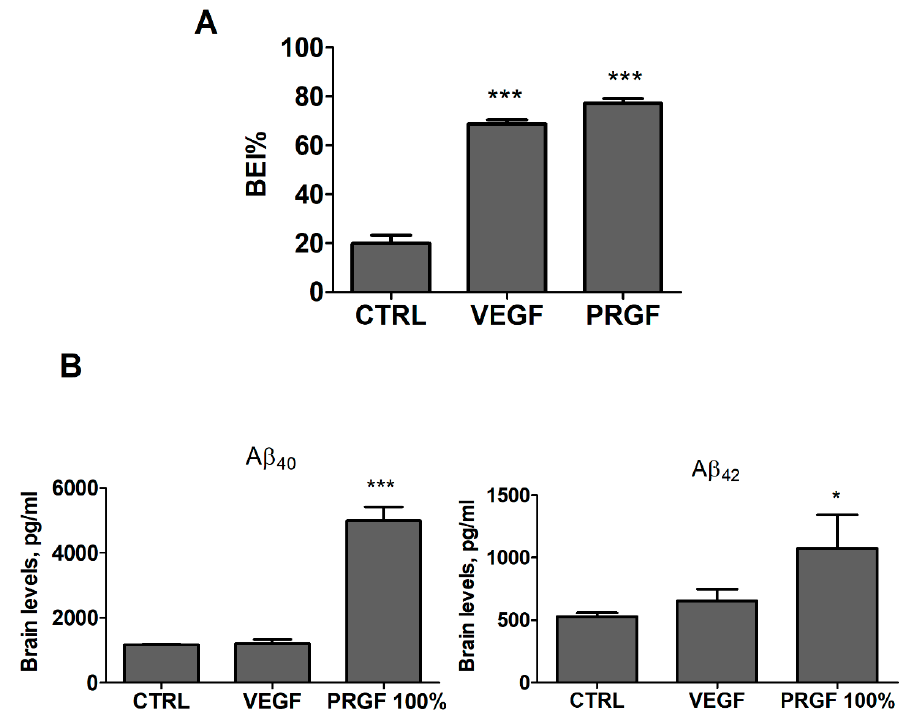
Figure 3. Effect of VEGF (100 pg/mL) and PRGF (100%) on A β brain levels in 5xFAD mice. ( A ) VEGF and PRGF enhanced the BEI % of exogenously administered 125 I-A β 40 across the BBB of 5xFAD mice brains. ( B ) The treatment with PRGF increased the total A β 40 and A β 42 levels, while VEGF had no effect on A β brain levels in mice brains as measured by ELISA. Data are presented as mean ± SEM ( n = 7 mice/group). * p < 0.05, *** p < 0.001 compared to control (CTRL) group.